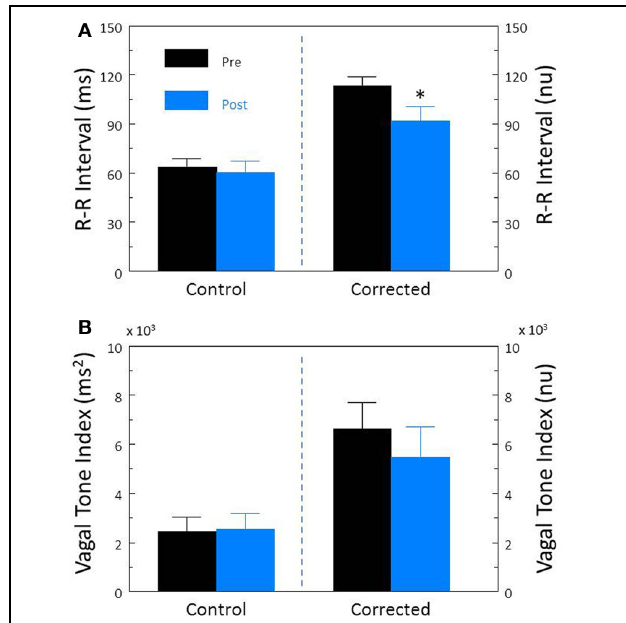
FIGURE 5 | The effect of the β -adrenergic receptor antagonist propranolol on heart rate variability. The effect of propranolol HCl (1.0mg/kg i.v.; n = 25) on total heart rate variability (standard deviation of R-R interval, RRSD) without and with correction (RRSD/mean RRsec) are displayed in (A) . The effects of this drug on the high frequency variability (cardiac vagal tone index, 0.24–1.04 Hz) without and with correction [cardiac vagal tone/(mean RRsec) 2 ] are shown in (B) . Note that after correction for propranolol-induced reductions in baseline HR, total (RRSD) heart rate variability significantly decreased following this treatment. ∗ P < 0 . 01 pre (black bars) vs. post (blue bars); pre = last 30s before propranolol administration, post = 30s interval recorded 5min after this drug treatment. nu, normalized units following HR correction.